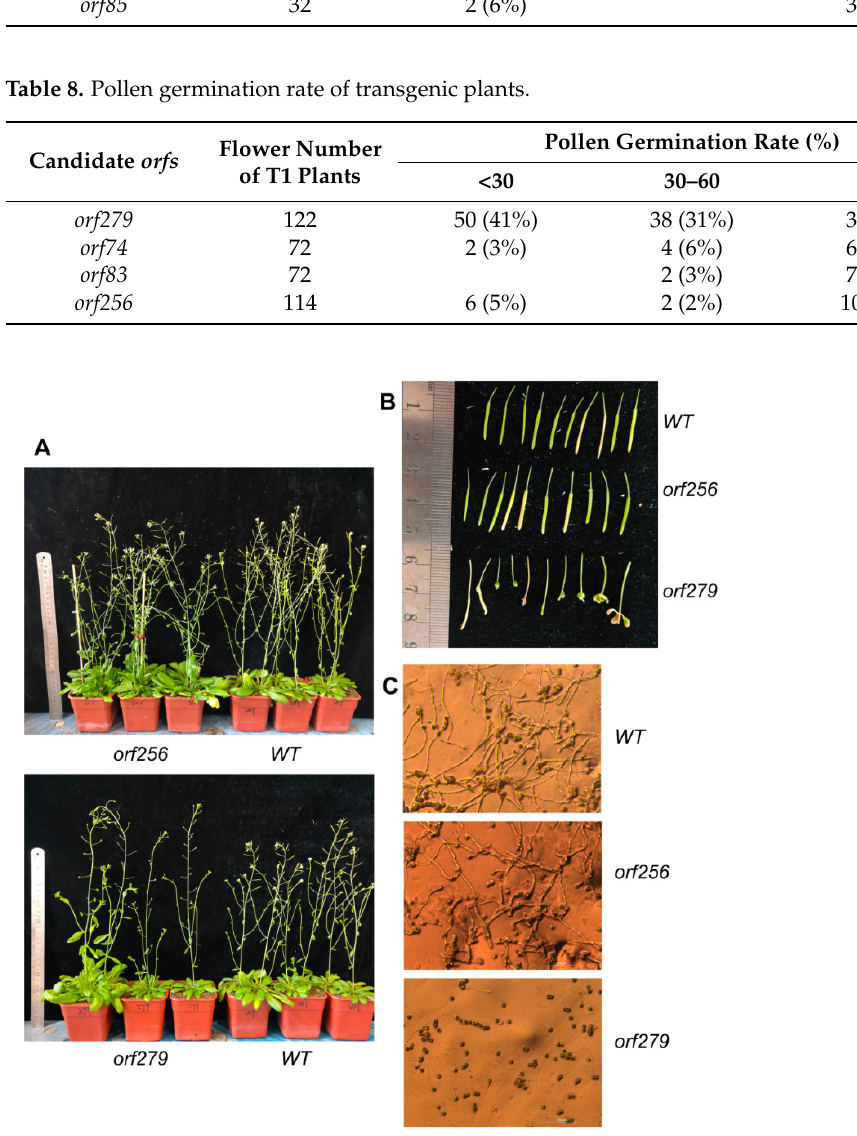
Figure 6. Phenotype of wild-type, orf256 and orf279 transgenic plants. ( A ) Transgenic plants; ( B ) siliques; ( C ) pollen germination rate, scale bar is 200 μ m.